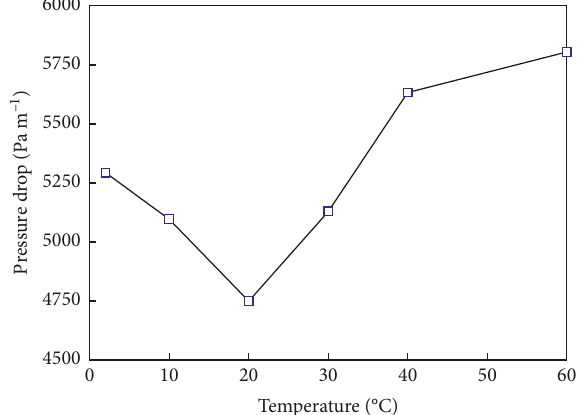
Figure 9: Effect of temperature on the pressure drop of paste